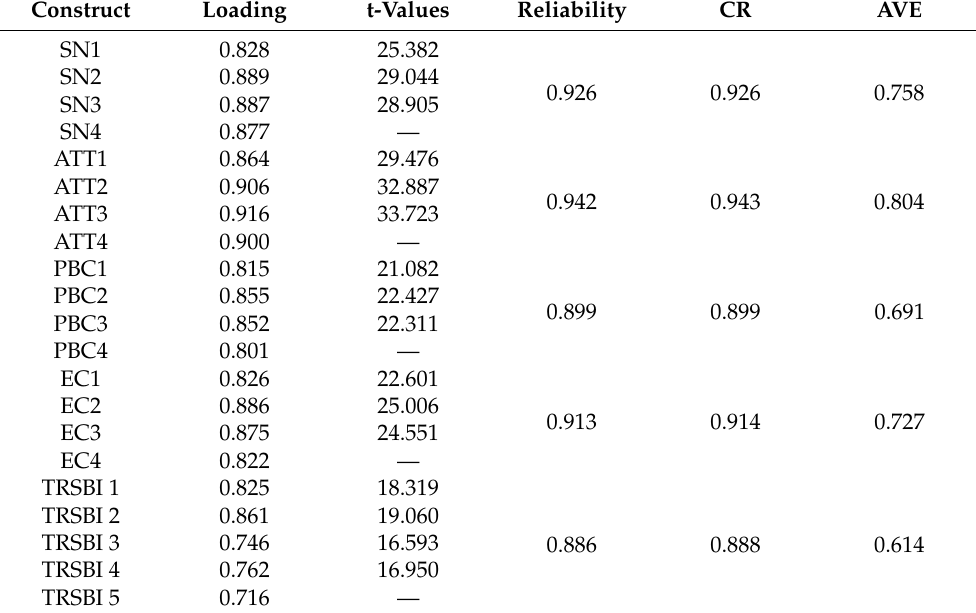
Table 2. Results of the measurement model.